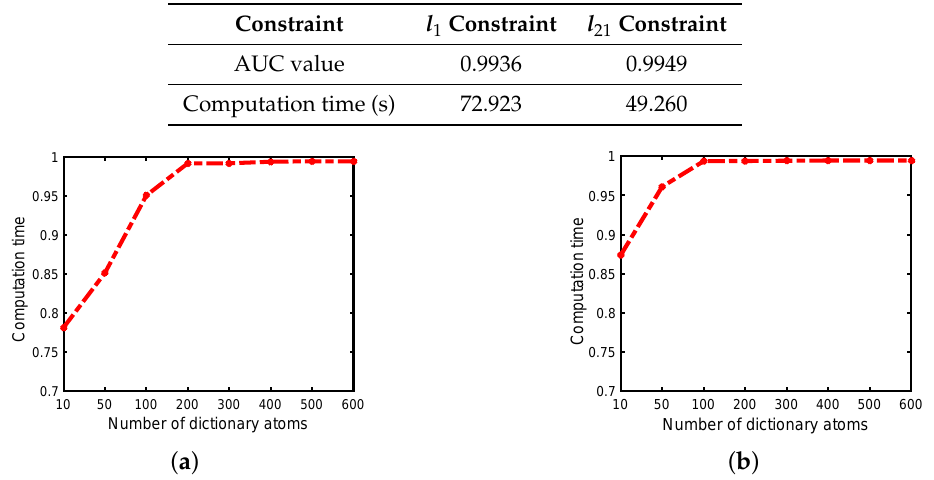
Figure 7. Color detection maps obtained by LRR with different constraints for the San Diego dataset. ( a ) l 1 constraint; ( b ) l 21 constraint. Table 2. Performance comparison of different constraints for the San Diego dataset.